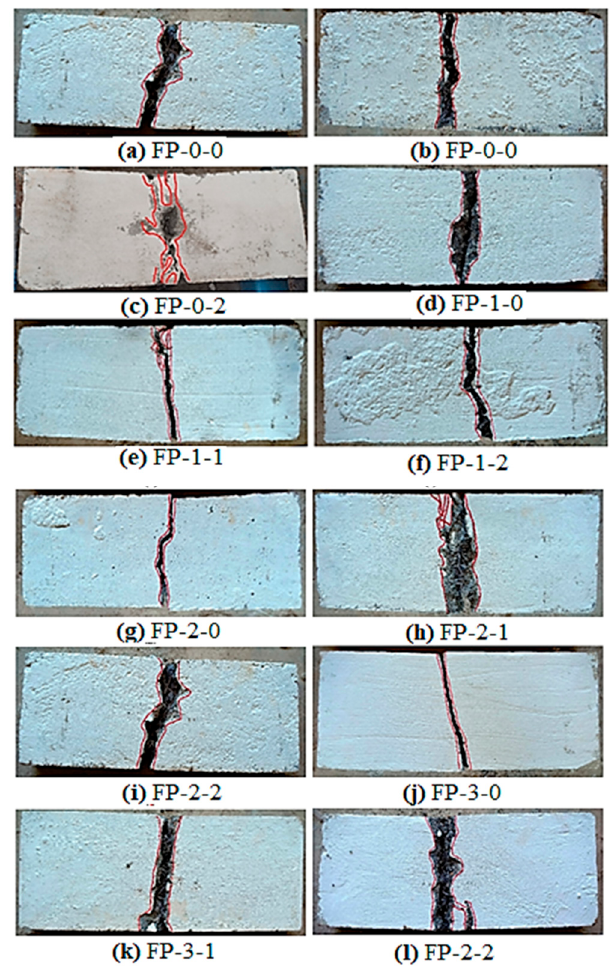
Figure 12. Failure mode of all teste ferrocement panel under impact load.